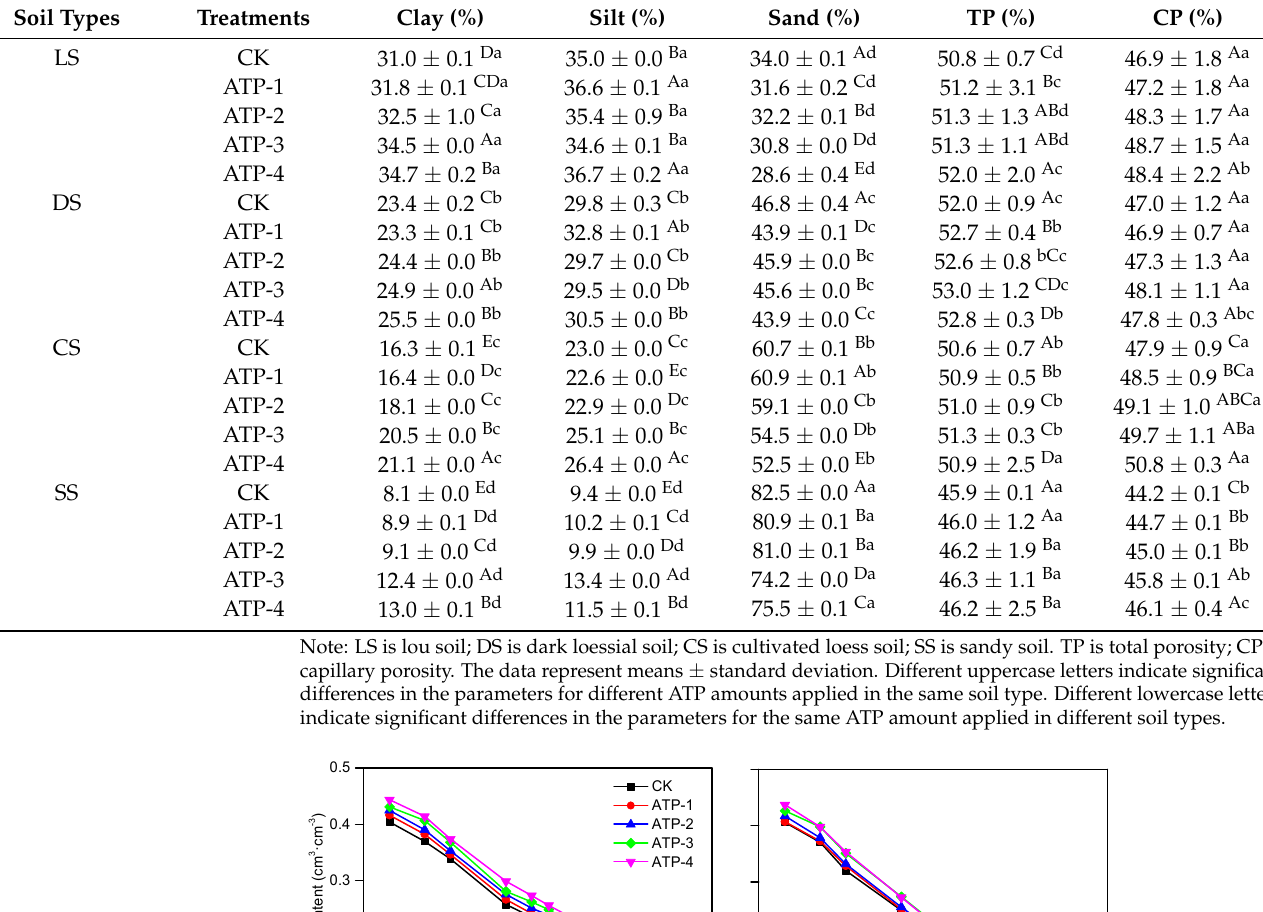
Table 2. Soil physical properties.